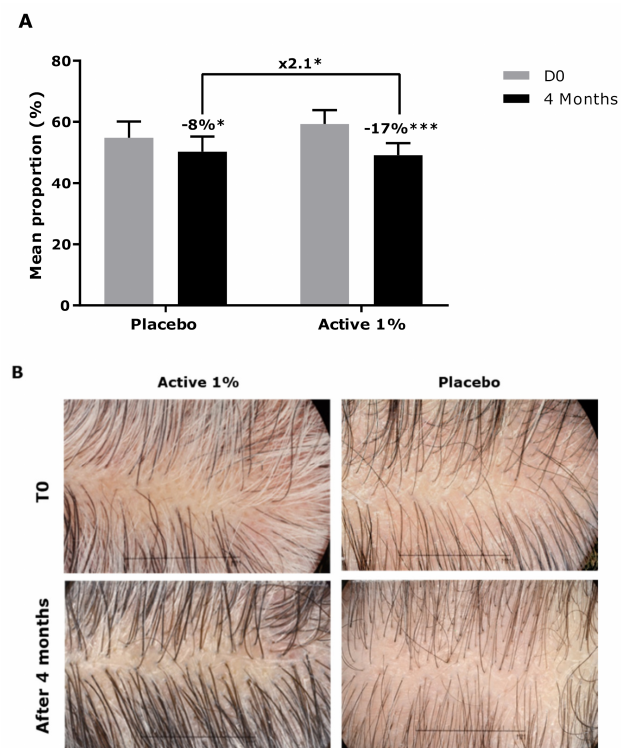
Figure 8. ( A ) Scoring of the proportion of grey hair (%) after 4 months of application. Data are presented as mean ± SD ( B ) Representative images of a volunteer who applied the active ingredient at 1% (Volunteer 7) and a volunteer who applied placebo (Volunteer 2). Statistical analysis was performed using a mixed ANOVA, with * p < 0.05, *** p < 0.001. The measure of grey hair density, which is a more quantitative method represented by the number of grey hairs per cm 2 , was performed on the volunteers. In Figure 9, the results showed that after 4 months of active product application, the number of grey hairs per cm 2 was significantly reduced by 14%, while the placebo application evidenced only a slight and not significant reduction of 5%. Interestingly, the active product showed a better and significant reduction of grey hair density than the placebo, with an efficacy that was 2.8 times higher (Figure 9).